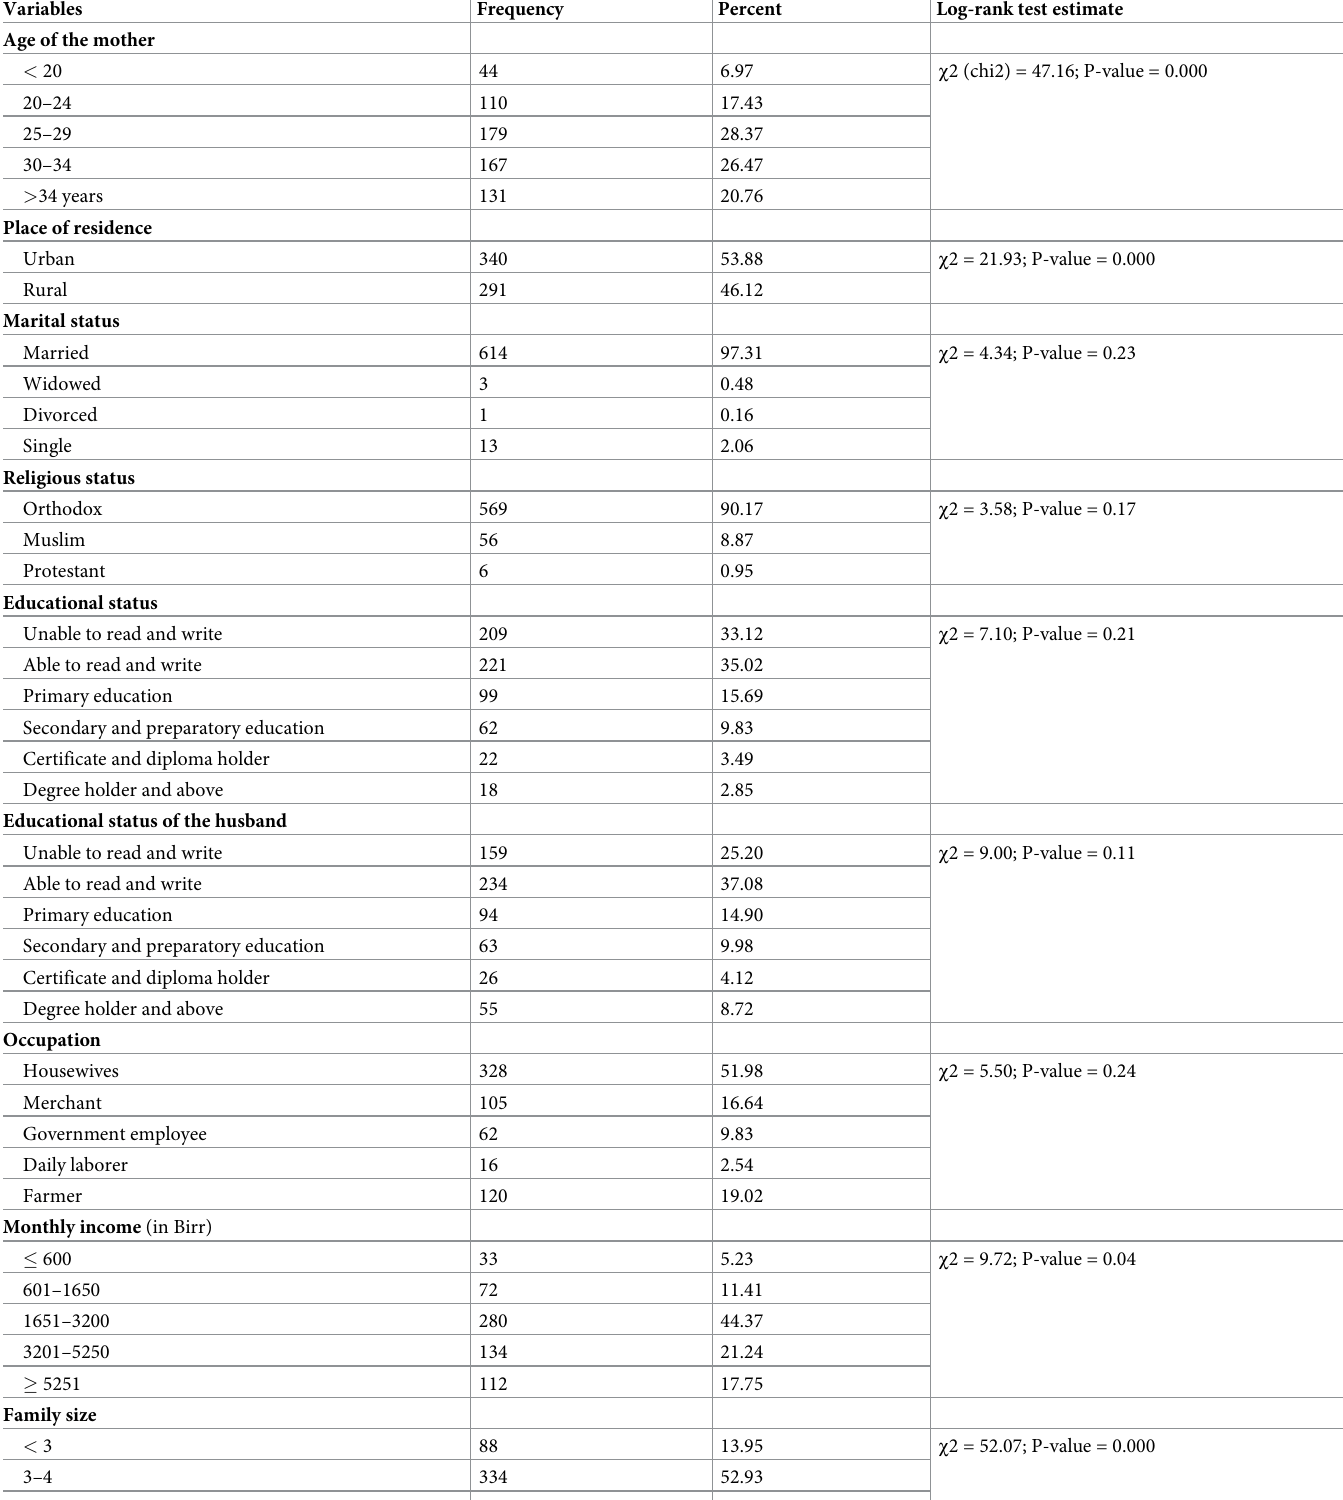
Table 1. Sociodemographic characteristics of the study participants in Public Hospitals of Central Gondar Zone, 2021 (n =